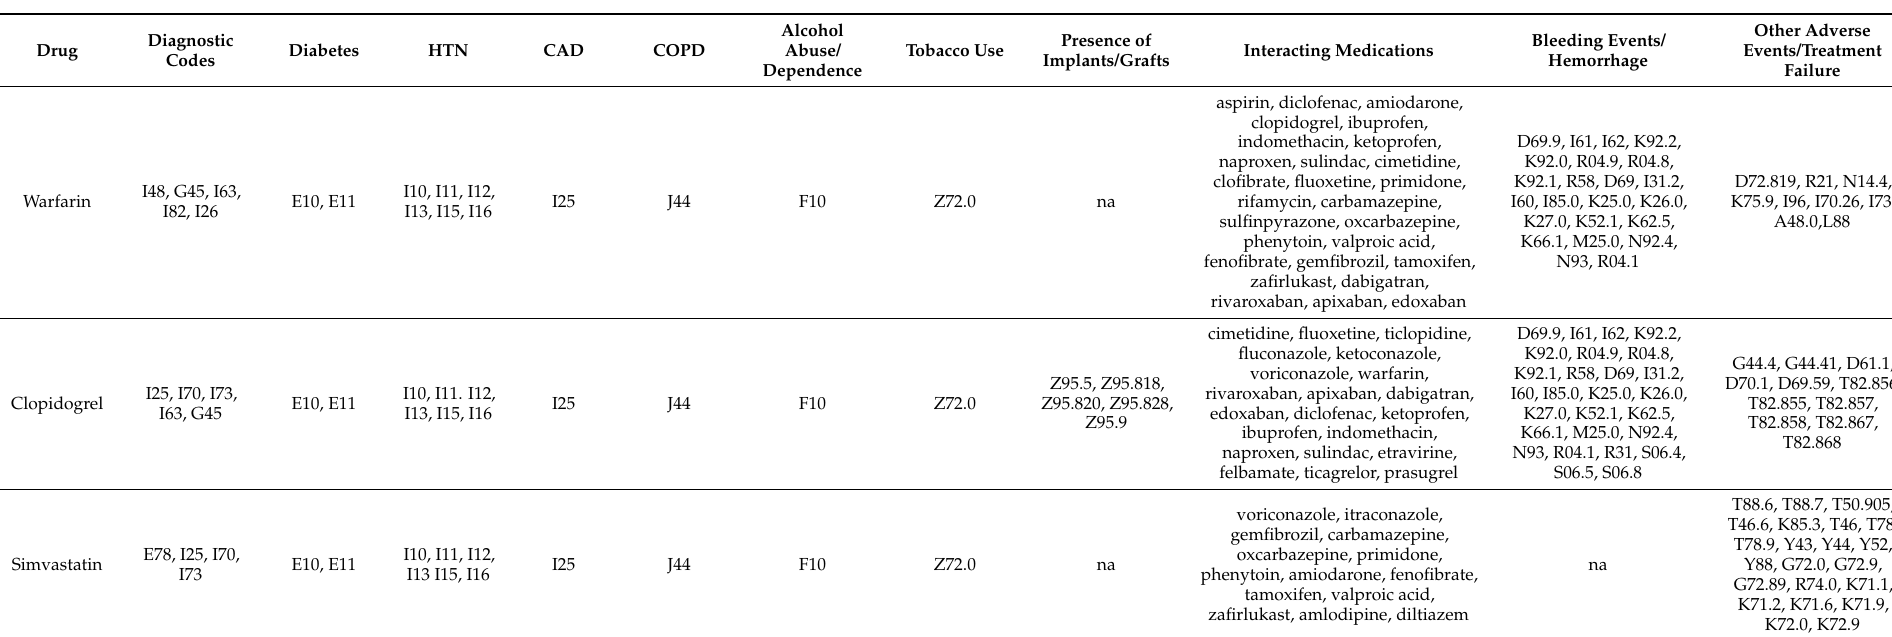
Table A1. List of International Classification of Diseases, 10th Revision (ICD-10) codes for co-variates, drug interactions and clinical